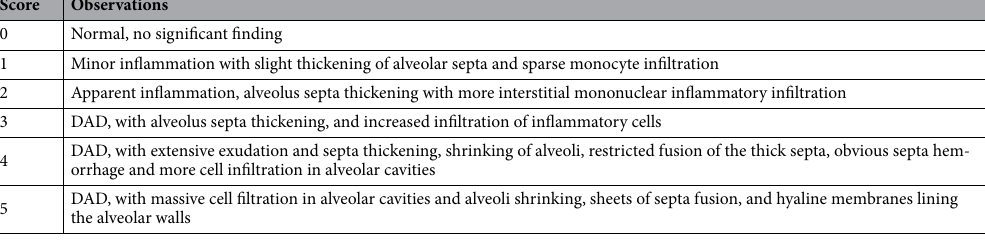
Table 1. Lung histopathology scoring system. DAD diffuse alveolar